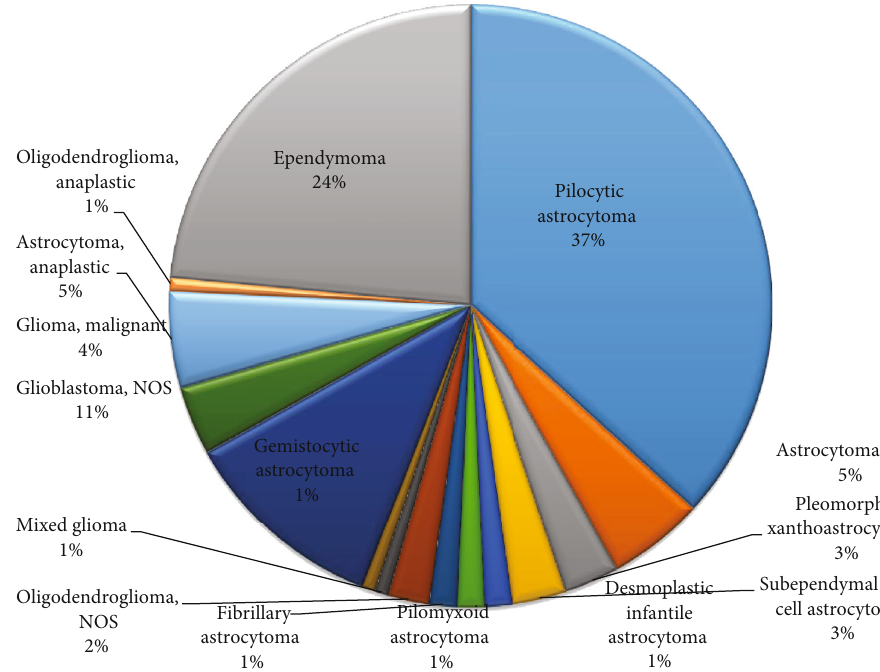
Figure 9: Distribution of all primary CNS gliomas by histologic subtype for children and adolescents (0-18